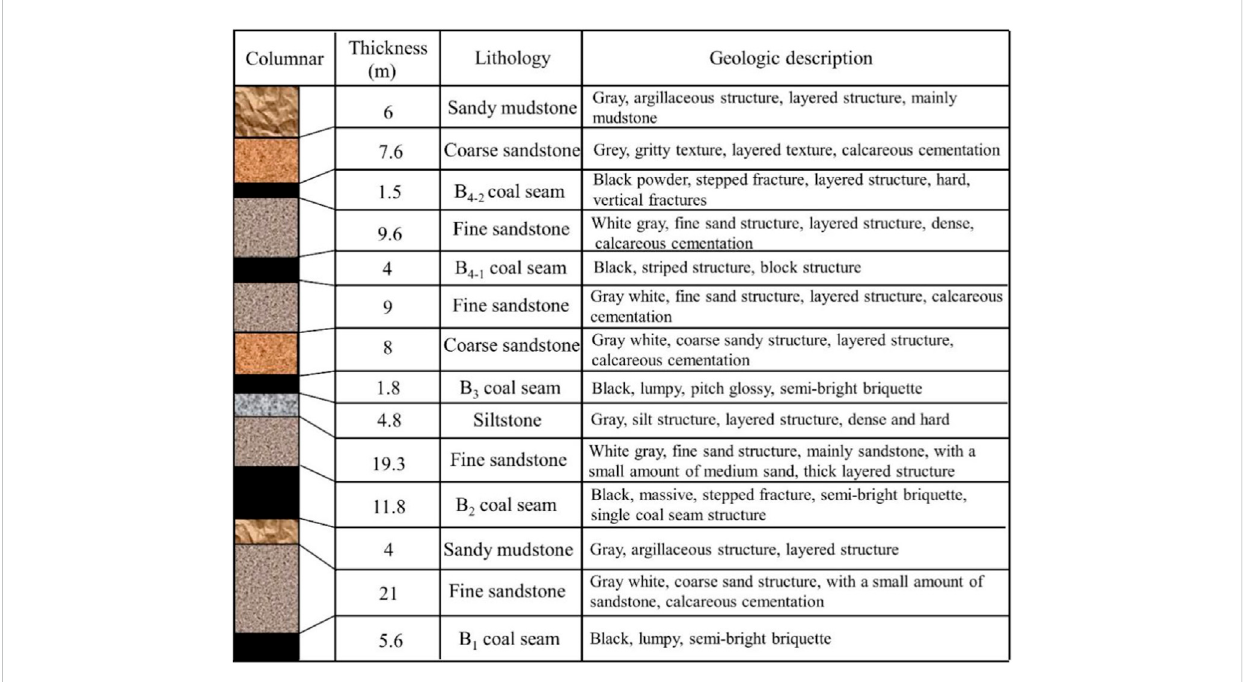
FIGURE 2 Thelithology of the rock layers near the B 2 coal seam.